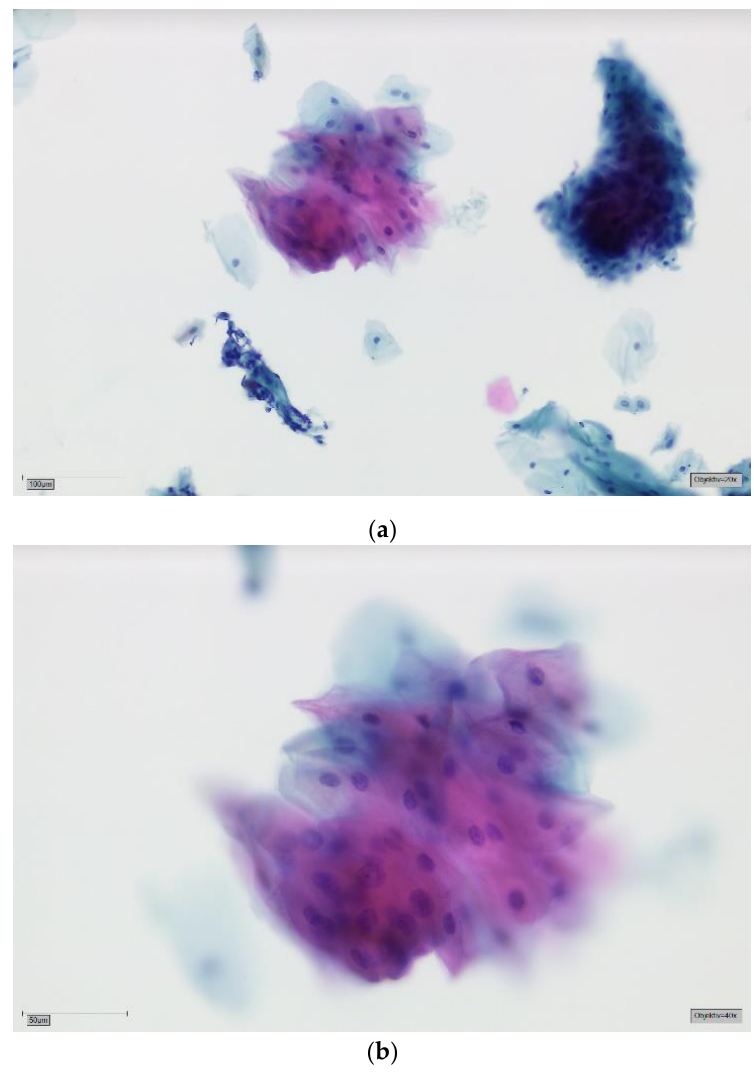
Figure 3. ( a ) Doubtful for tumour cells—SurePath, staining Papanicolaou, lens 20 × . Clinically erosive OLP. The background is mostly clear. In the lower left field is a stromal tissue fragment with mechanically altered nuclei; this correlates with an erosive process. There are several mature squamous cells lying singly and three larger groups of cells. In the upper right field, the basophilic cells are more immature, a sign of regeneration. The group of mature cells in the upper central field shows cytoplasmic hypereosinophilia and amphophilia. There seems to be some degree of anisonucleosis. ( b ) Doubtful for tumour cells—detail, lens 40 × . On high power and in this plane of focus marked variation in nuclear size can be appreciated (factor 2–3). The larger nuclei are rather darker, i.e., more hyperchromatic, and the chromatin is slightly coarse. Nuclear contours are still fairly smooth. These findings are commonly reactive. A mild squamous intraepithelial neoplasia (SIN1) cannot be excluded. We perform DNA-karyometry on these cases. DNA-aneuploidy should prompt invasive biopsy for histology. With DNA-euploidy we would recommend clinical follow-up and repeat brush cytology after 12 months.